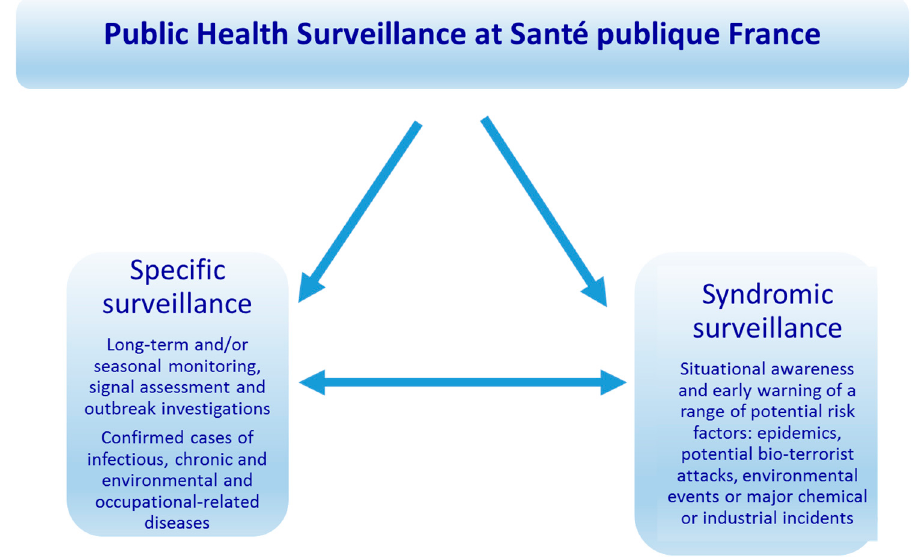
Figure 5. Public Health Surveillance at Santé publique France.